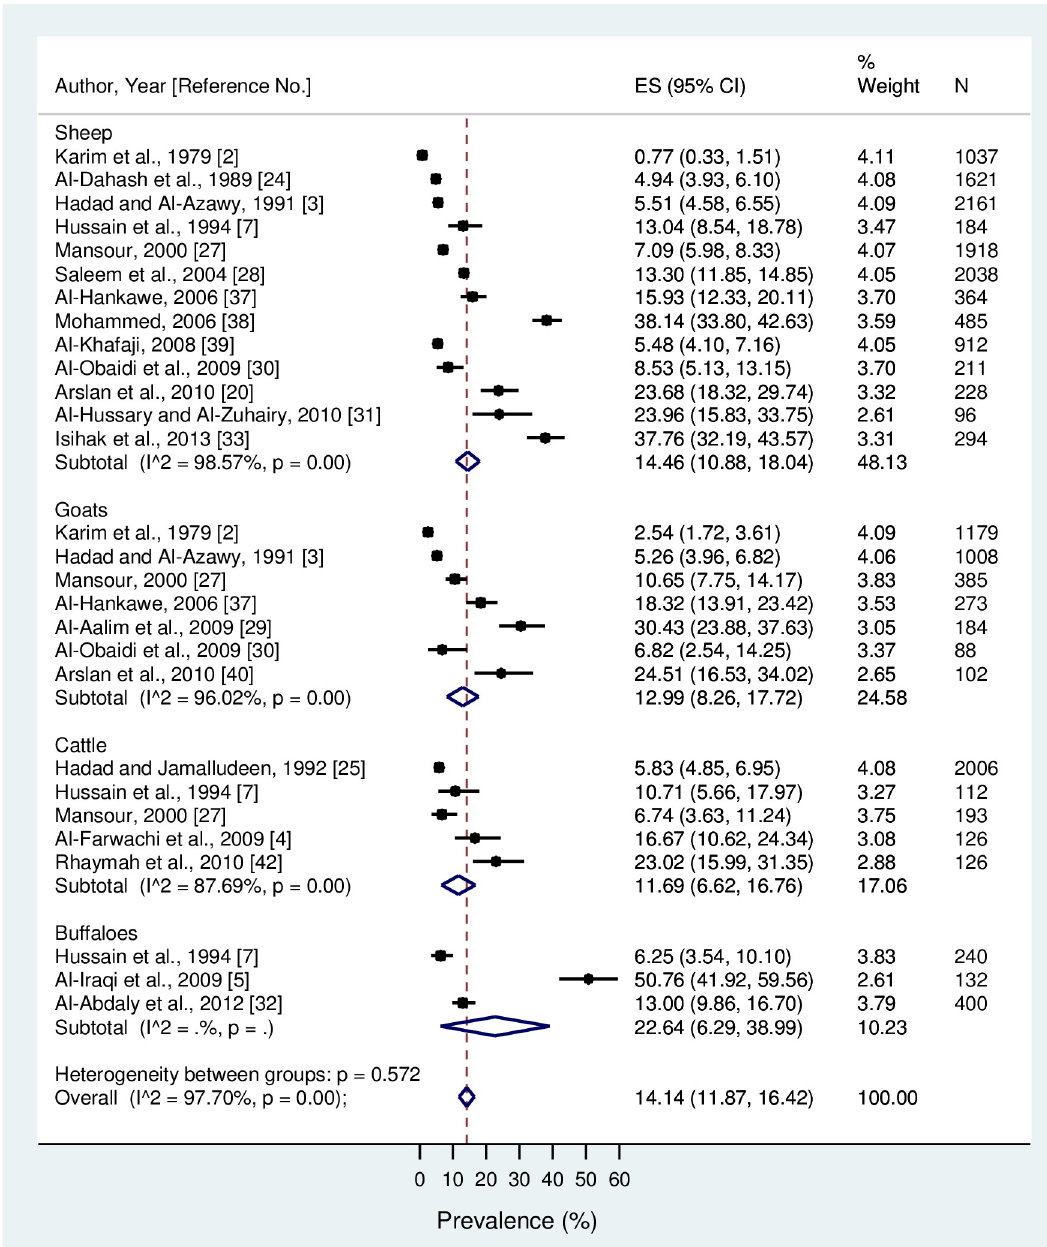
Fig 2. Forest plot for seroprevalence of brucellosis in food-producing animals in Mosul, Iraq. Studies assessed different serological test for diagnosis of brucellosis. A total of 11 stud- ies assessed different serological tests for diagnosis of brucellosis, mainly ELISA in comparison to the traditional rapid test (i.e., RBT). The outcome in the identified studies was binary; posi- tive/negative for brucellosis. Cohen’s kappa statistic ( κ ), therefore, is usually conducted to measure the agreement in this type of evaluation [55, 56]. However, only 4 studies used κ to evaluate the diagnosis using ELISA in comparison to RBT [4, 5, 20, 40]. In those studies, the estimated values of κ were between 0.229 and 0.38; indicating that the agreement was fair [55,